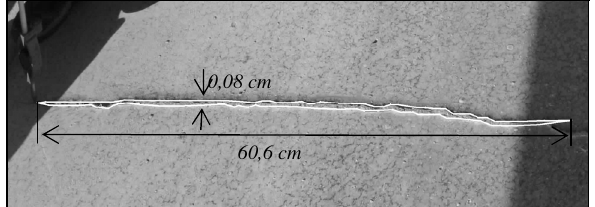
Fig 4. Measurement of the break of road